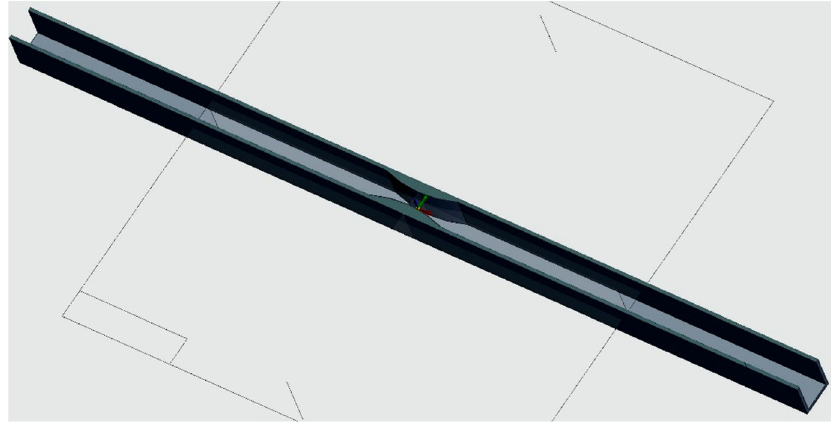
Figure 7. Rectangular specimen with consolidation (inside view).